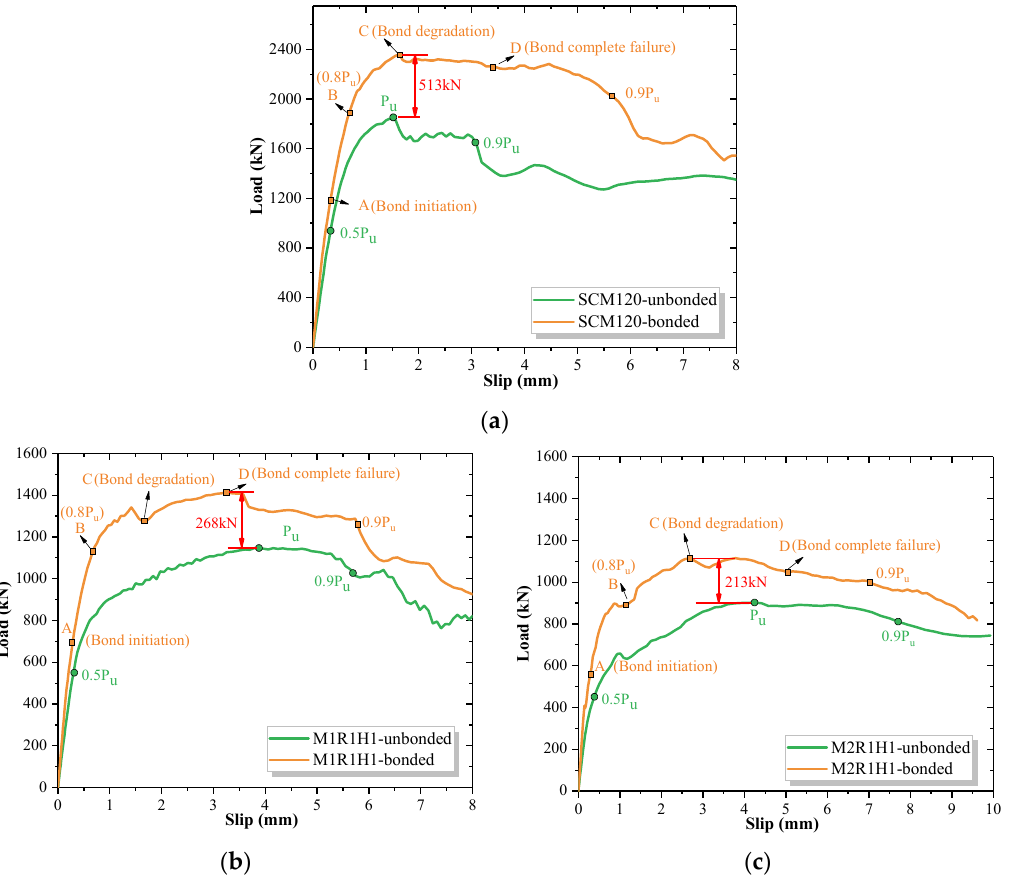
Figure 13. Comparison of load slip curves between bonded and unbonded specimens: ( a ) SCM120 specimen; ( b ) M1R1H1 specimen; ( c ) M2R1H1 specimen.